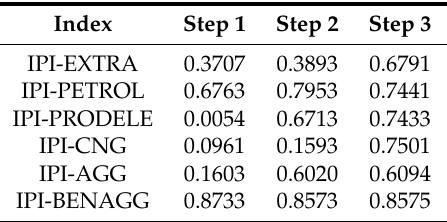
Table 28. Comparison of the ratio between mean absolute errors with an expanding window for electricity from 2015:01 to 2018:12.